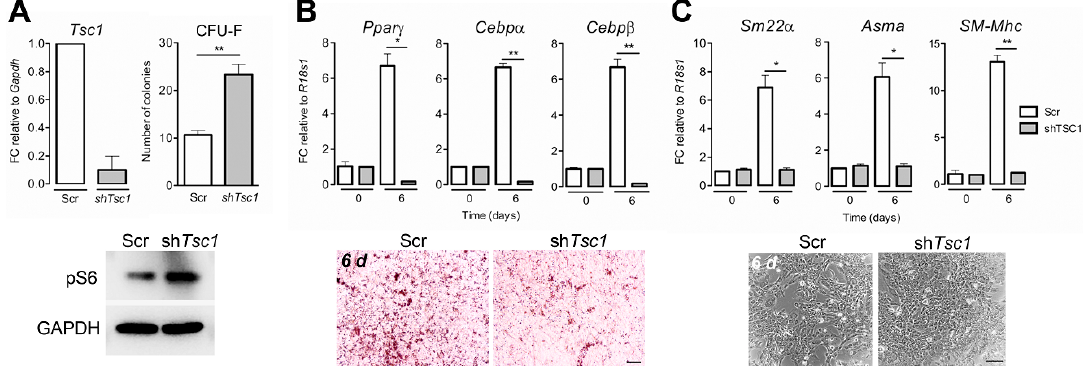
Figure 5. shRNA-mediated knockdown of Tsc1 in wt BM-MSCs enhances clonogenicity and suppresses adipocyte and SM di ff erentiation. ( A ) Relative Tsc1 mRNA levels, colony number (CFU-F) and pS6 protein levels in mouse (C57BL / 6) BM-MSCs were transduced with sh Tsc1 and Scr sequences. Gapdh was used as a housekeeping control for RT-PCR and immunoblot. ( B ) Adipocyte di ff erentiation of sh Tsc1- and Scr-transduced BM-MSCs. Relative mRNA levels of Ppar γ , Cebp α , and Cebp β before (day 0) and after 6 days of adipogenic stimulation (day 6). r18s1 was used as a housekeeping control. Images (below) show oil red o staining of transduced BM-MSCs after 6 days of adipogenic di ff erentiation. Scale bar: 100 µ m. ( C ) Smooth muscle di ff erentiation of shTsc1- and Scr-transduced BM-MSCs. Relative mRNA levels of Sm22 α , Asma , and SM-Mhc before and after 6 days of myogenic stimulation. The images (below) show the cellular organization of transduced BM-MSCs after 6 days of SM differentiation. Scale bar: 100 µm. Data presented are means ± SD, n = 3, per group. * p < 0.05; ** p < 0.01.